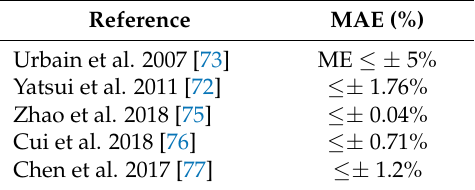
Table 6. MAE/ME of KF based SOC estimation